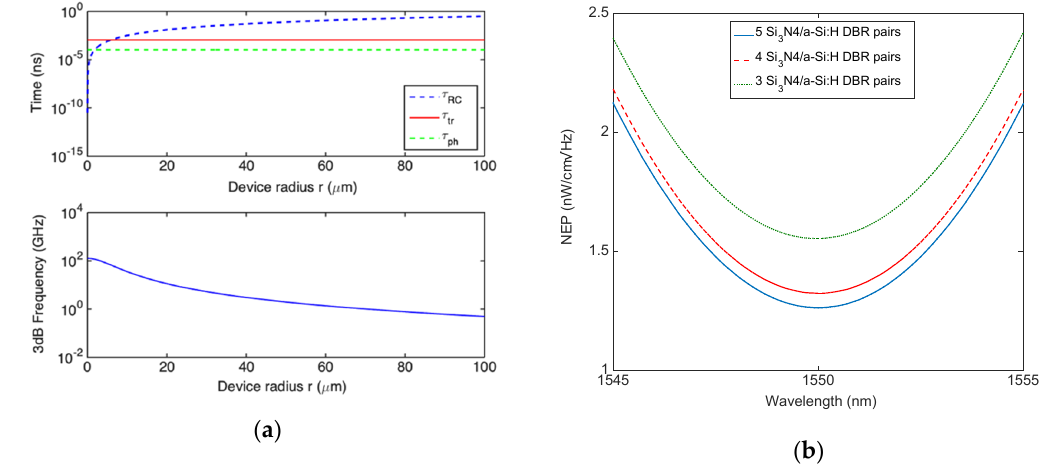
Figure 11. ( a ) Carriers transit time τ tr , charge/discharge time τ RC , cavity photon lifetime τ ph and 3 dB roll-off frequency versus graphene disk radius r for the LCC Fabry–Pérot graphene/Si Schottky PD provided of a DBR output mirror constituted by 5 pairs of Si 3 N 4 /a-Si:H and ( b ) spectral NEP.